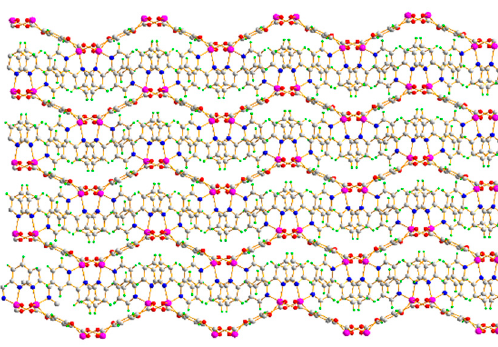
Figure 3. The 3D network structure of the complex.